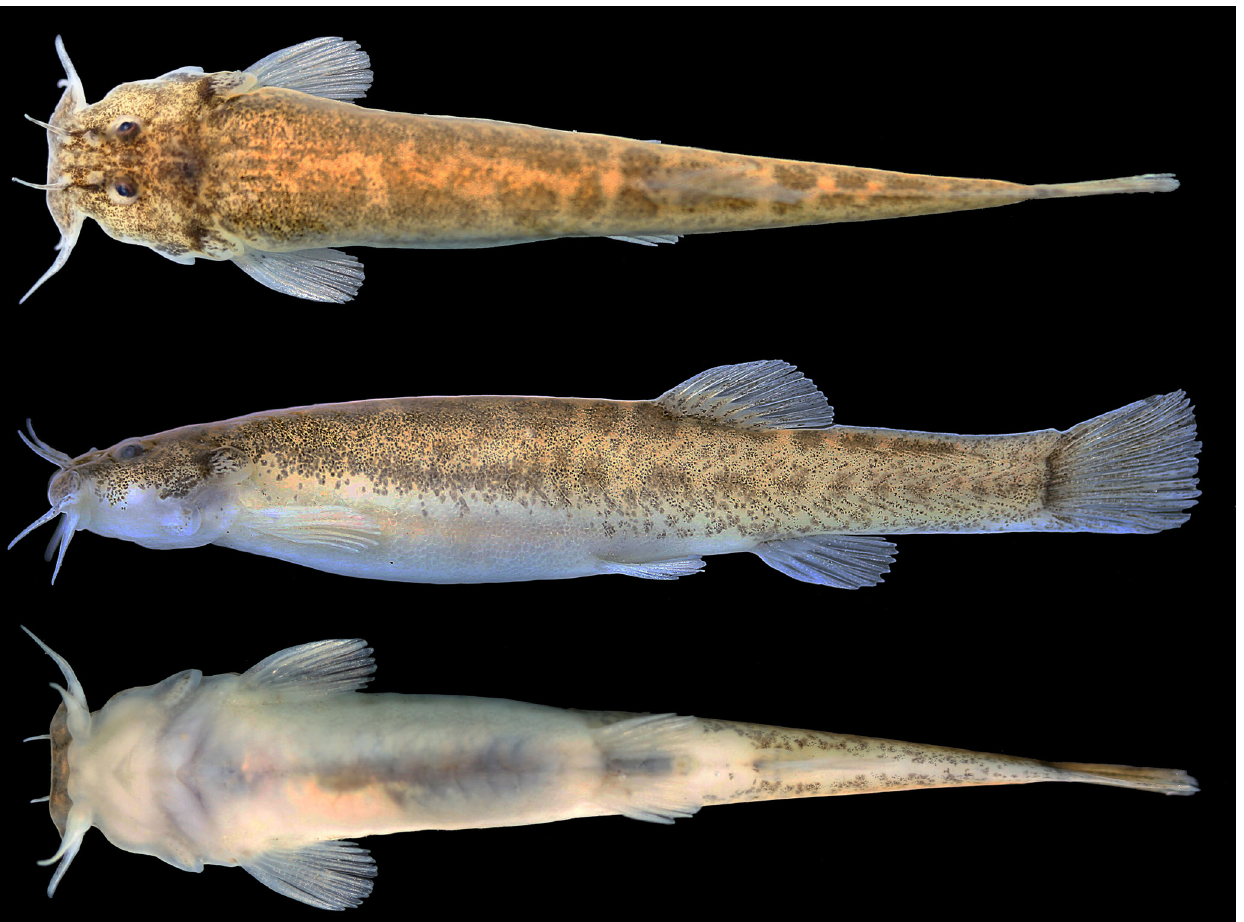
FIGURE 6 | Scleronema guapa just after the fixation in formalin, holotype (UFRGS 23500; 36.4 mm SL), Brazil, Rio Grande do Sul State, Rosário do Sul, sanga Santo Antônio, tributary to rio Ibicuí da Armada, lower rio